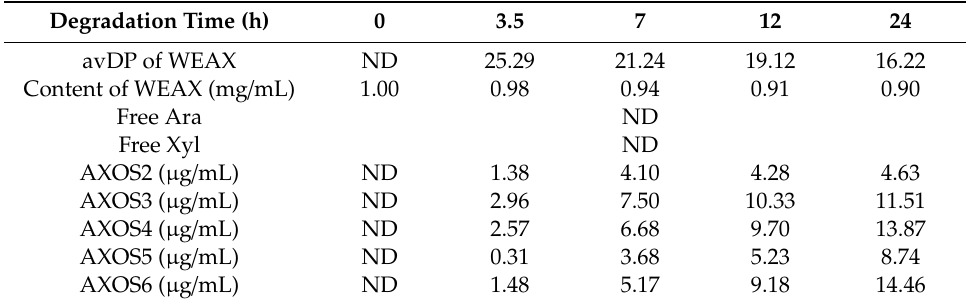
Table 5. Average degree of polymerization (avDP), content of water-extractable arabinoxylan (WEAX), and arabinoxylan-oligosaccharides (AXOS) content after